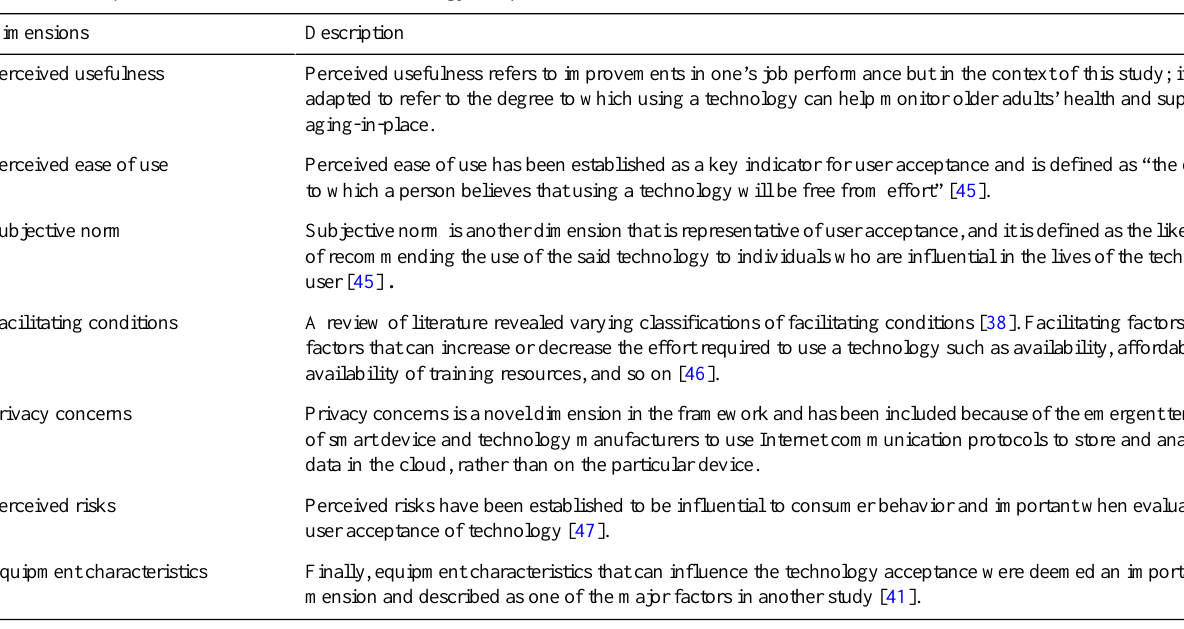
Table 2. Description of dimensions related to technology